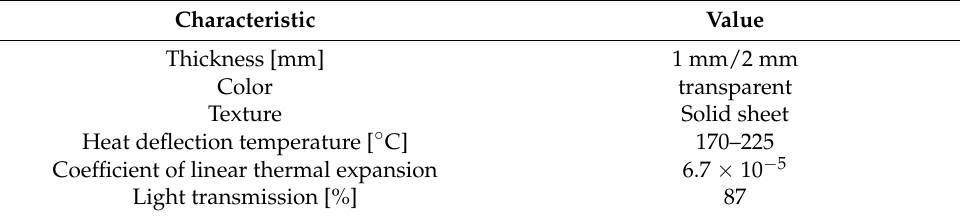
Figure 2. The dimensions of the part to be obtained. Table 1. Technical specifications of the polycarbonate sheets.